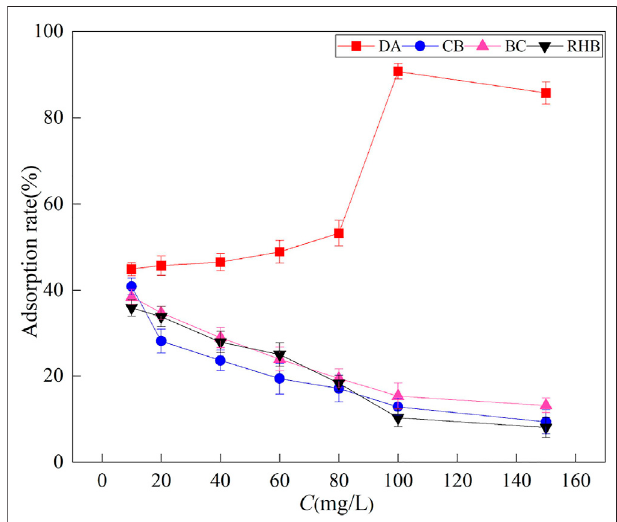
FIGURE 3 | Infrared spectra of the four adsorbent materials.